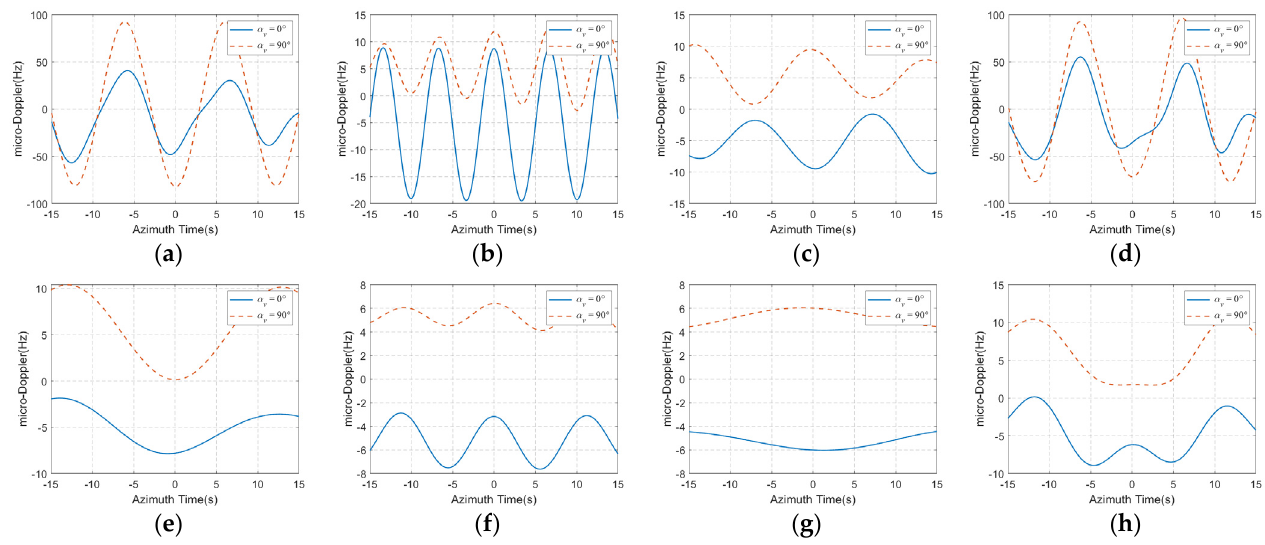
Figure 9. The micro-Doppler of point P introduced by ship oscillations. ( a ) Destroyer, roll motion; ( b ) destroyer, pitch motion; ( c ) destroyer, yaw motion; ( d ) destroyer, all the three angular oscillations; ( e ) carrier, roll motion; ( f ) destroyer, pitch motion; ( g ) destroyer, yaw motion; ( h ) carrier, all the three angular oscillations.